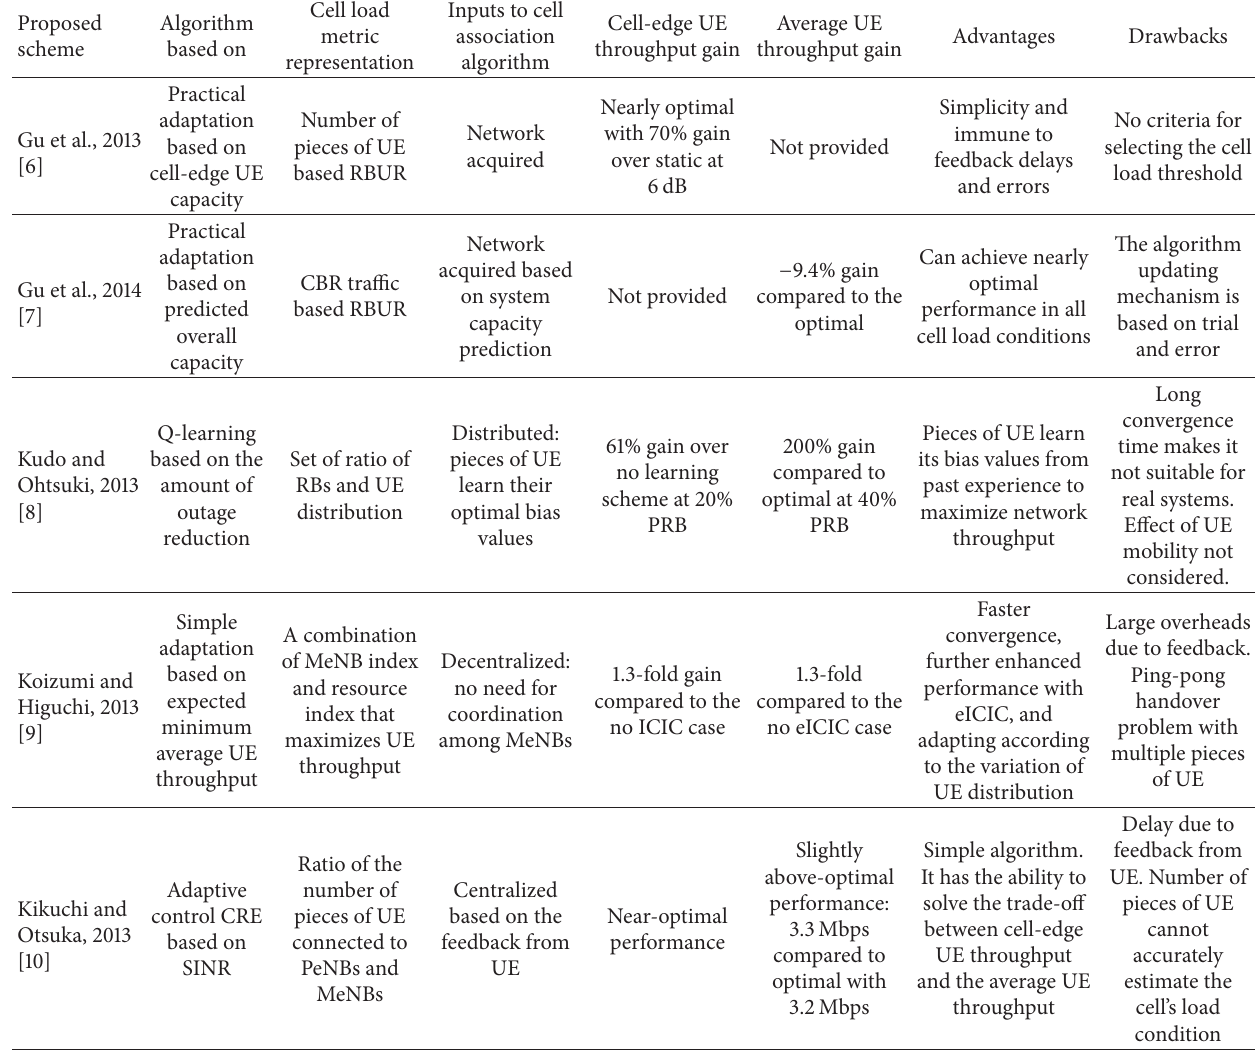
Table 1: A comparative summary of the adaptive cell association